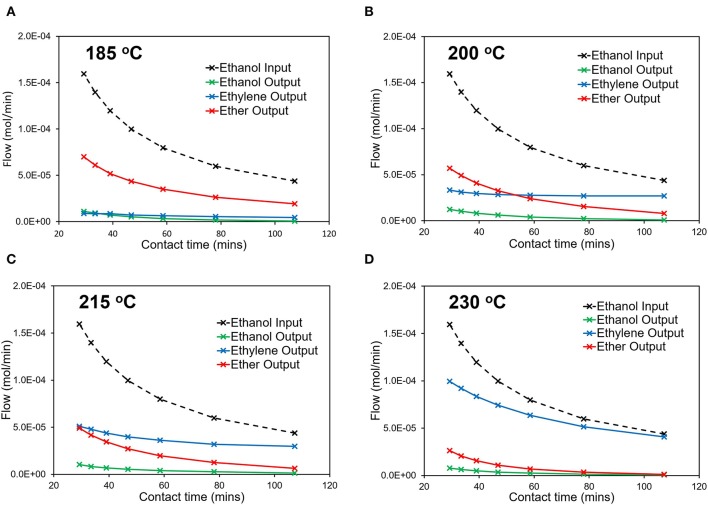
Catalytic data detailing how the output stream composition varies with contact time at (A) 185°C, (B) 200oC, (C) 215oC, and (D) 230°C.